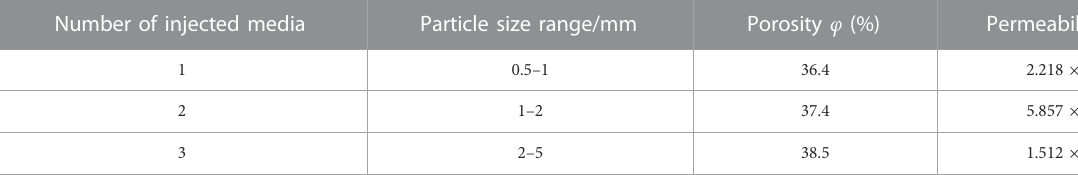
TABLE 1 The physical and mechanical parameters of injected medium.